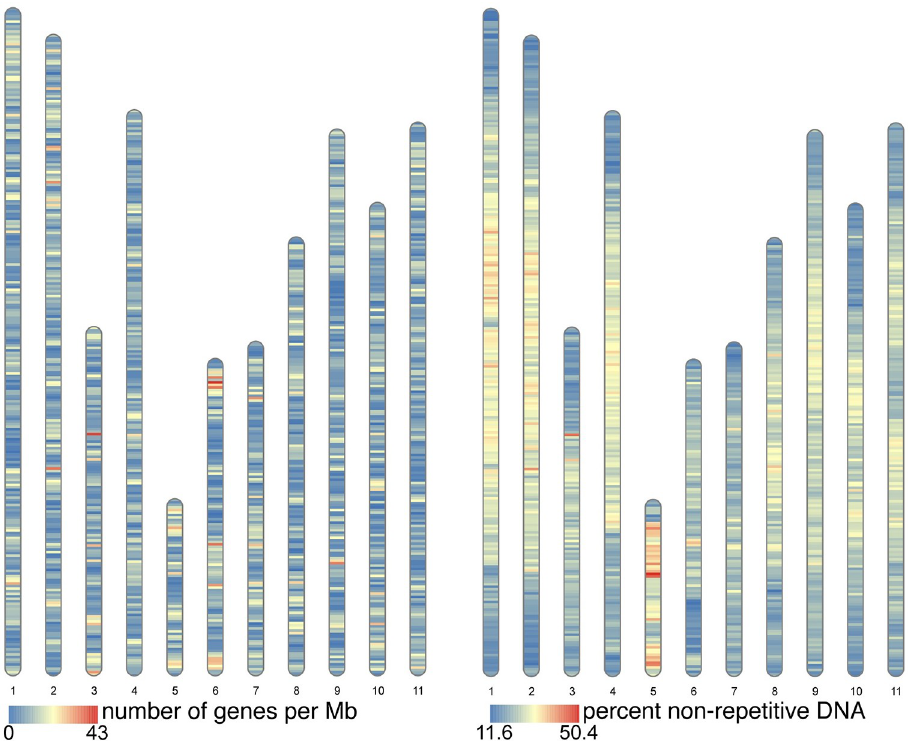
Fig 3. Heat map of gene density and non-repetitive DNA per 1 Mb sliding window. The 11 chromosomes are in the same order as in the Hi-C heat map (Fig 1) and fasta file of the genome. Repetitive content higher towards the distal portions of the chromosomes.